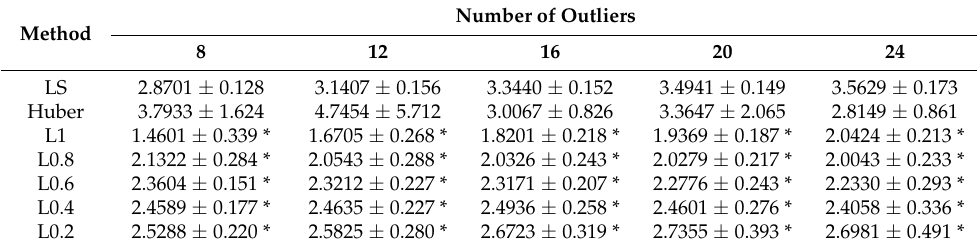
Table 2. Fitting errors of the SISO system with different numbers of outliers.